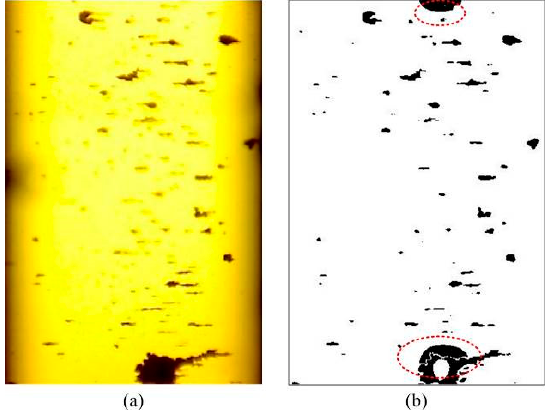
Figure 6. Results after removing low-frequency UDCT coefficients from a ferrogram with large wear debris (red circles show wrongly detected particles). ( a ) Large-size debris in the ferrogram; ( b ) erroneous binarization results.